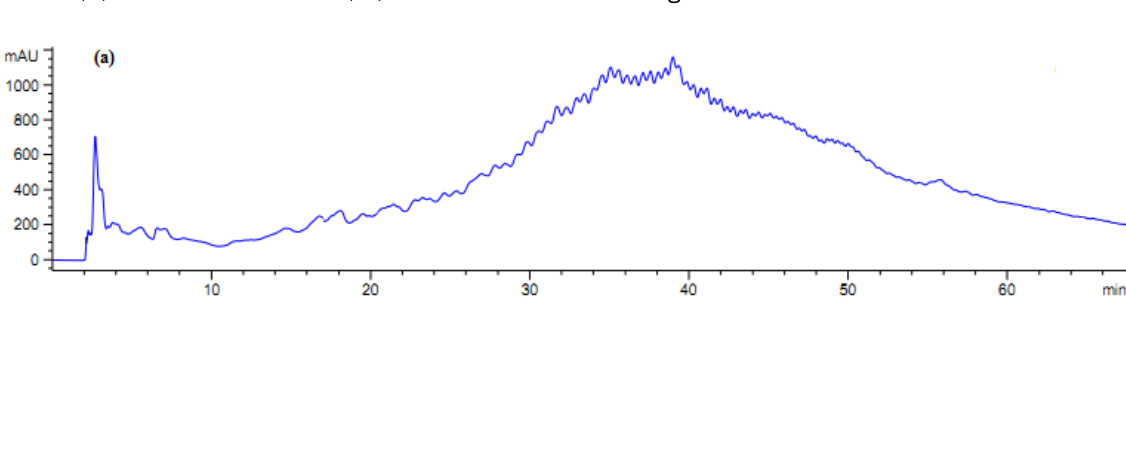
Figure 5. Fractionation of A. lecanora bromelain generated hydrolysate (after 7 h hydrolysis) by semi-preparative RP-HPLC. ( a ) Chromatogram of A. lecanora hydrolysate; and ( b ) Growth inhibition (%) of collected fractions against E. coli